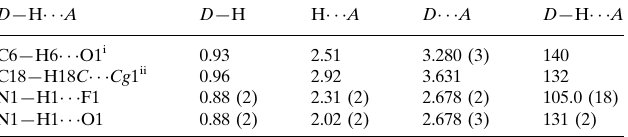
Hydrogen-bond geometry (A˚ , (cid:1)